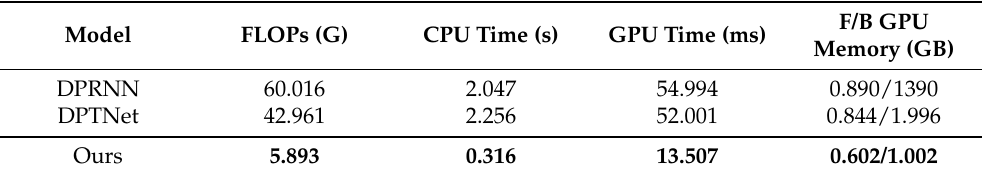
Table 4. Floating point operations, runtimes, and memory occupations of different networks. The best results are shown in bold font.